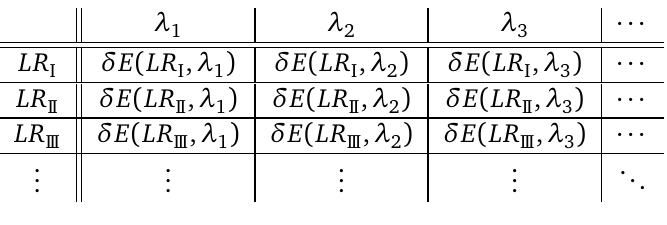
Table 1: Matrix M constructed from the energy shifts obtained with different long- and short-range